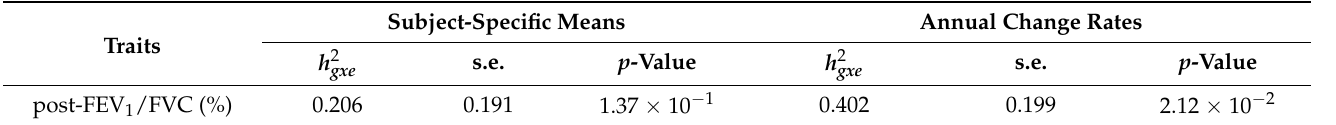
Table 3. Heritability of SNP–smoking interaction for annual change rates with significant p -value ( p <